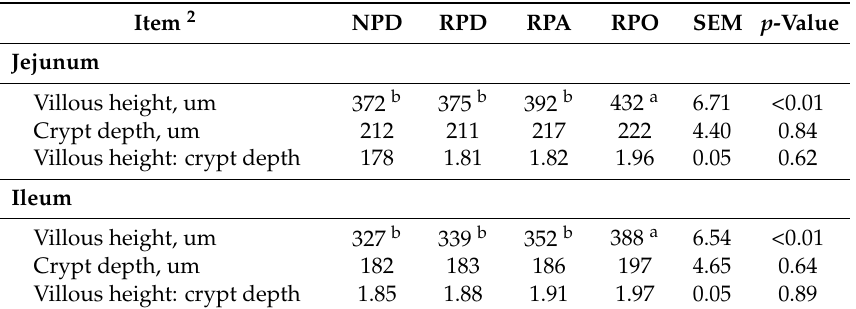
Table 5. Influences of inclusion of oregano essential oil in a low-protein diet on intestinal morphology of growing-finishing pigs 1 .